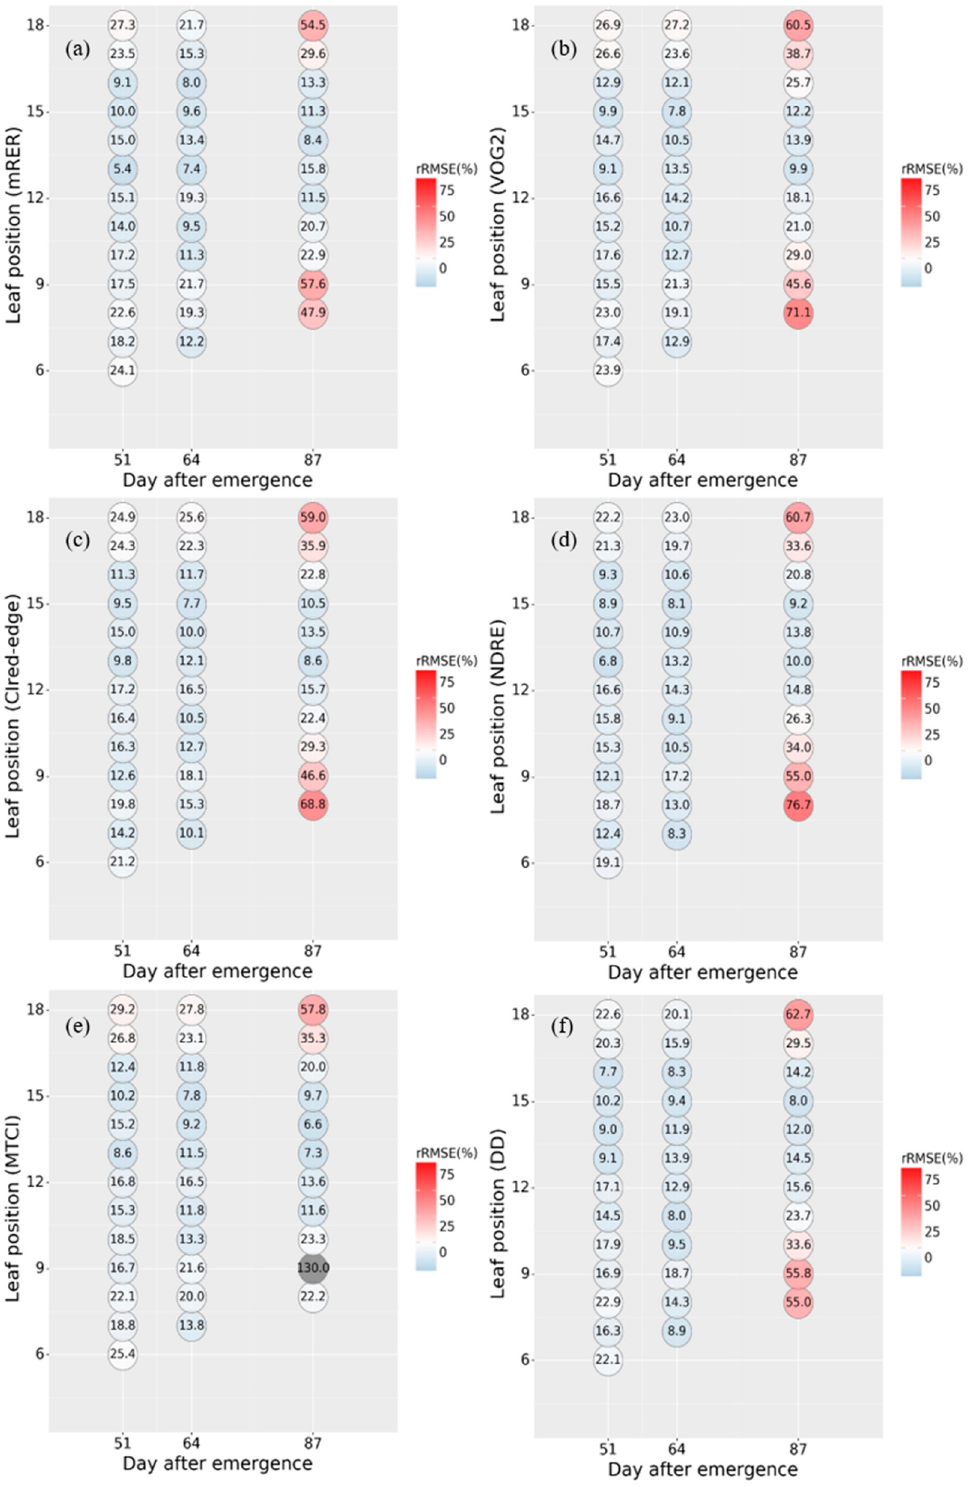
Figure A1. rRMSE (%) of the six LCC–VI models (2019): ( a ) mRER, ( b ) VOG2, ( c ) CIred-edge, ( d ) NDRE, ( e ) MTCI, and ( f ) DD. rRMSE was used to evaluate the consistency of model inversion.